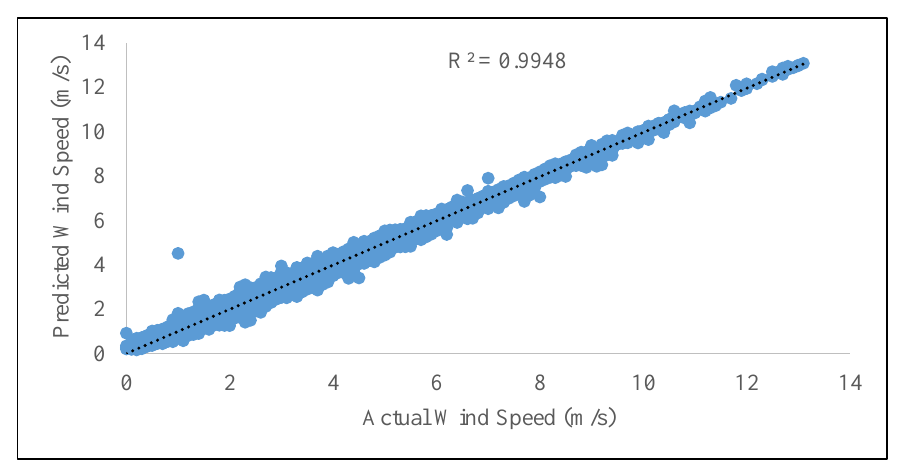
Figure 11. Actual vs. predicted wind speed for test data.